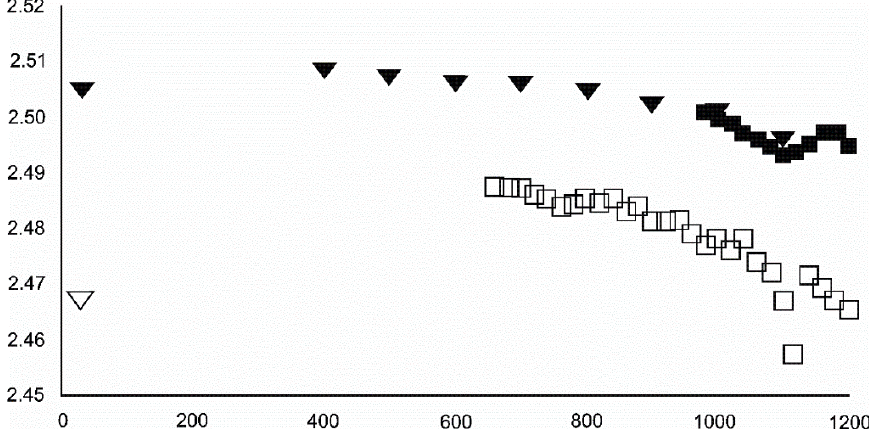
Figure 16. Relationship of temperature (bottom axis, in °C) to FWHM (left axis, as 2 θ angular difference) for olivine. LSCB data—filled symbols. USCB data—empty symbols. Squares—heating- related data. Triangles—cooling-related data.